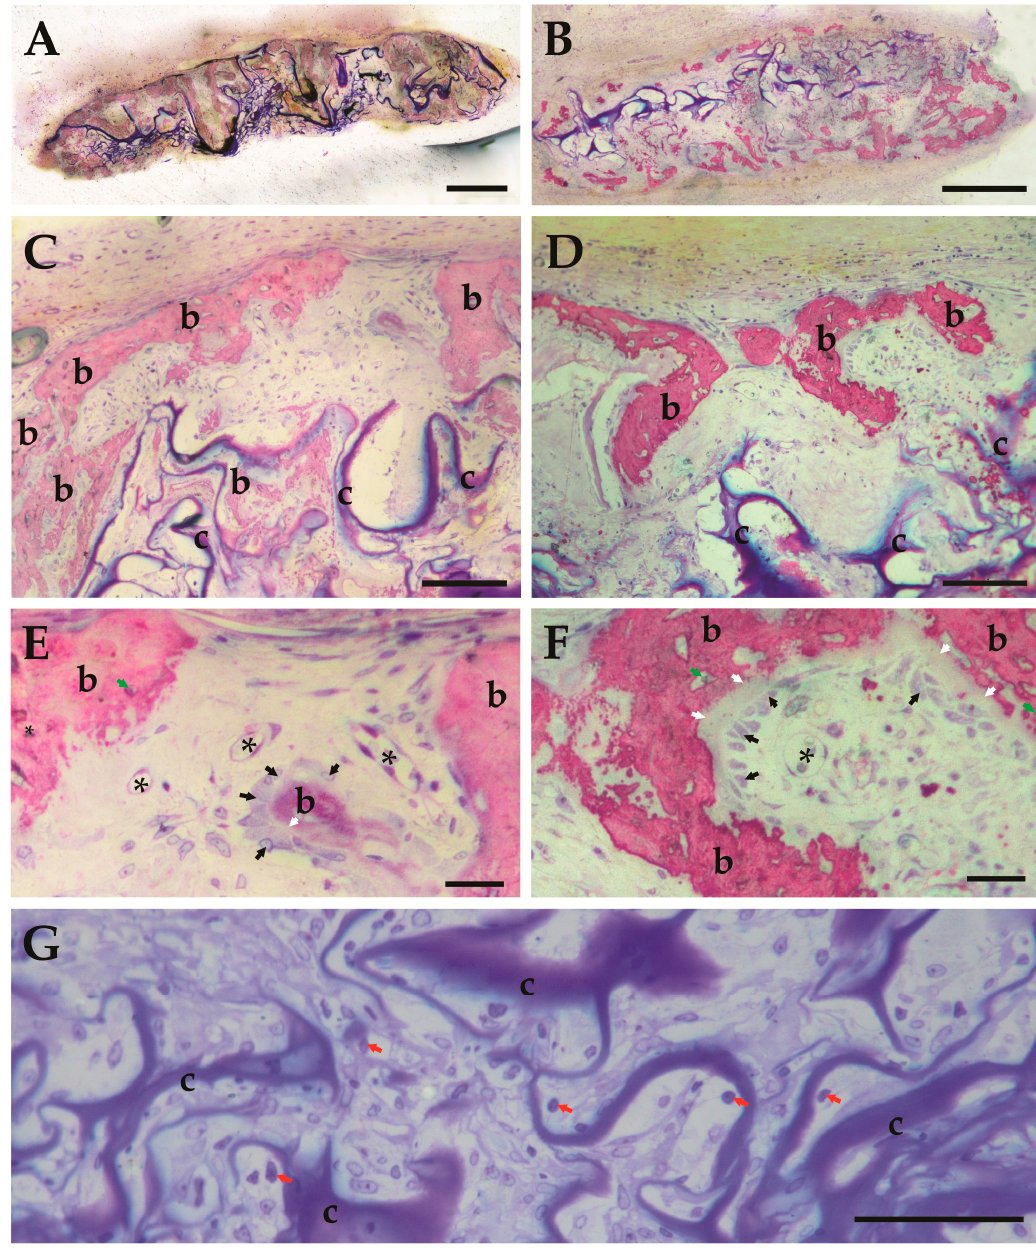
Figure 6. Light micrographs of BMP-2/ACS constructs, in the presence or absence of 100 µ g/mL HA (48 kDa) at time of retrieval (18 days) at low ( A , B ) and high ( C – G ) magnifications: ( A , C , E , G ): BMP-2 10 µ g+HA; ( B , D , F ): BMP-2 10 µ g in the absence of HA. ( A ) illustrates homogenous bone forming activities throughout the construct, whereas in B formation of new bone tissue occurs preferentially at the interface of the construct with the native tissue. ( C , D ) illustrate the newly-formed bone tissue (b) in these two groups at higher magnifications and remaining collagen carrier material (c). ( E , F ) illustrate the blood vessels (*) and unmineralized bone areas (white arrow); osteoblasts (black arrow). In ( E , F ), the newly-formed woven bone shows a typical irregular pattern of osteocyte distribution (green arrow) within the mineralized bone matrix (pink-red stained areas). In ( E ) larger numbers of blood vessels (*) are present compared to ( D ); ( G ) illustrates the macrophages (red arrow) within BMP-2/ACS constructs. Magnification bars in ( A , C ): 500 µ m; in ( C , D , G ): 100 µ m; in ( E , F ): 25 µ m.